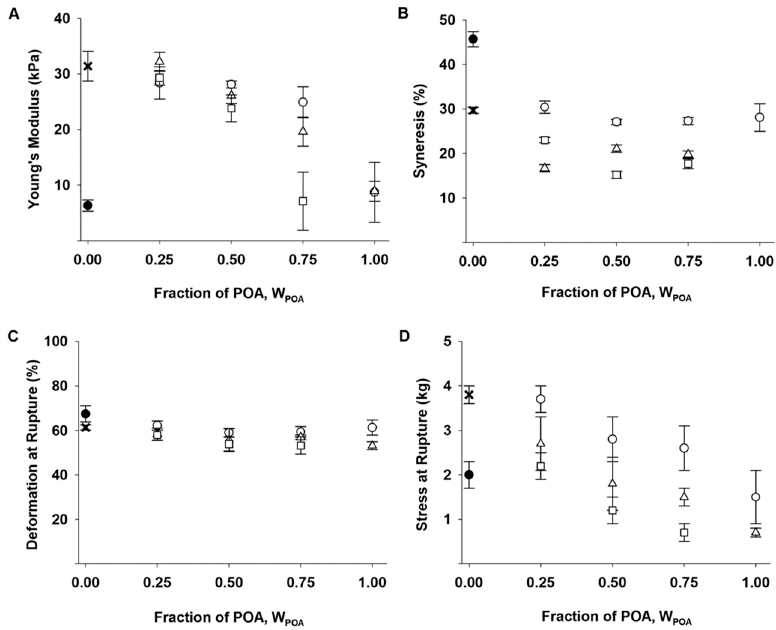
Figure 3. Mechanical characterization of 1.0% w/v mixed Ca-saturated hydrogels of stipe alginate